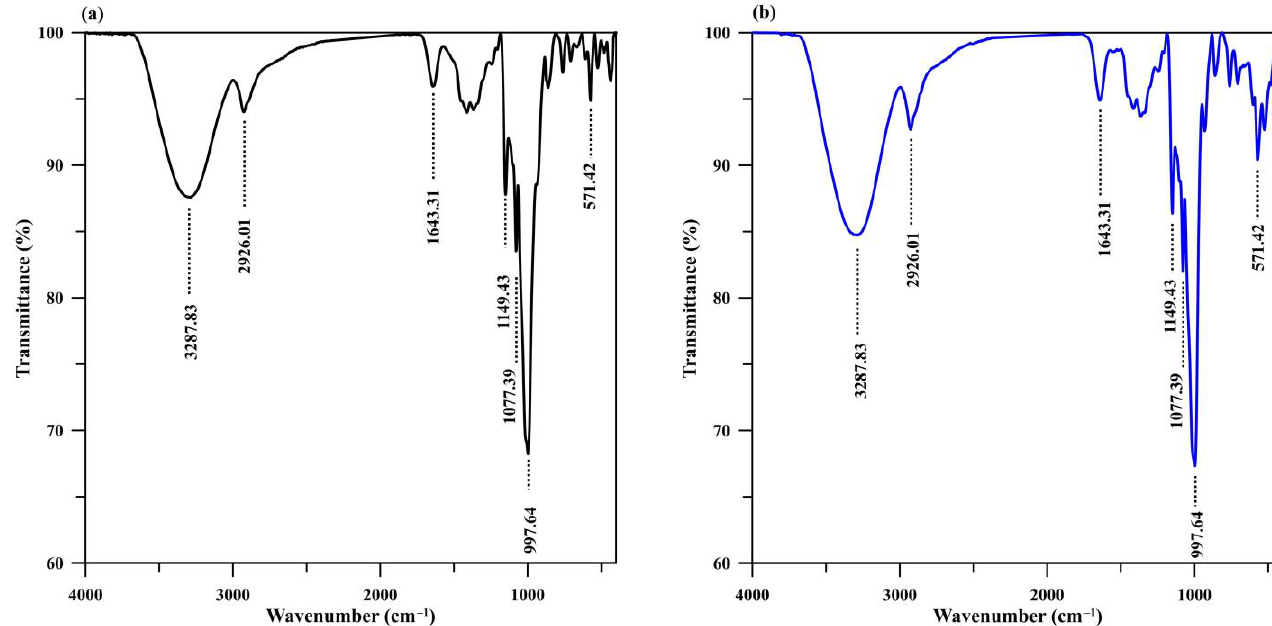
Figure 4. FTIR spectra of Cry – CSH ( a ) before and ( b ) after phosphate